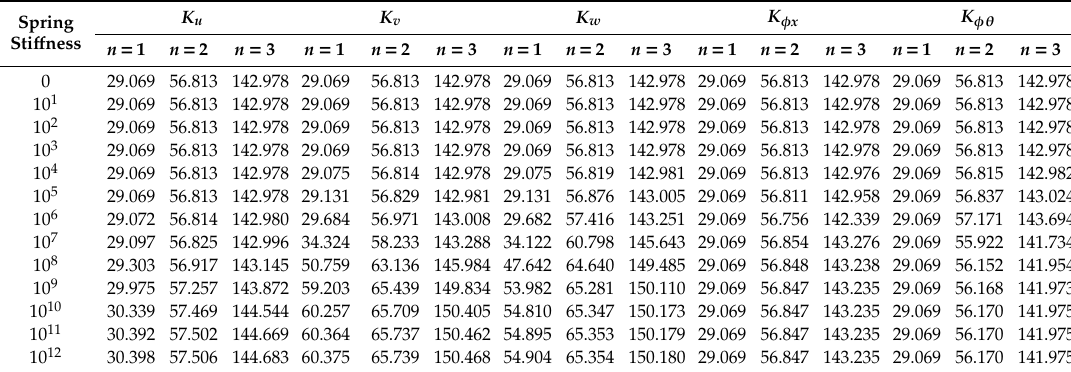
(cid:112) ρ Table 8. The frequency parameters Ω = ω L 2 / E 2 / h for a three-layered cross-ply [0 ◦ / 90 ◦ / 0 ◦ ] composite laminated cylindrical shell with S-elastic boundary conditions, one displacement is under elastic restrained and others are free ( L / R = 4, h / R = 0.1, E 2 = 2 GPa, E 1 / E 2 = 25, µ 12 = 0.25, G 12 = 0.5 E 2